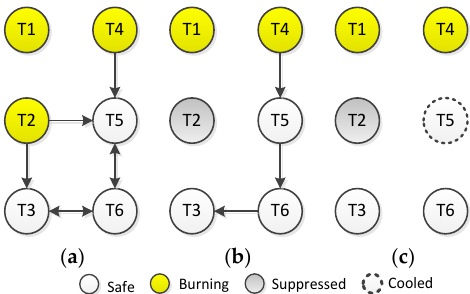
Figure 4. Optimal firefighting strategy for Scenario 2. ( a ) T1, T2, and T4 are all on fire. ( b ) T1 and T4 are on fire while T2 is suppressed. ( c ) T1 and T4 are on fire, T2 is suppressed, and T5 is cooled.